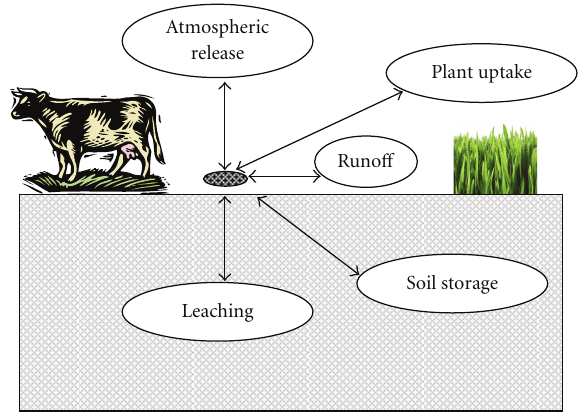
Figure 1: General components of nutrient cycling in grazed pastures (Adapted from